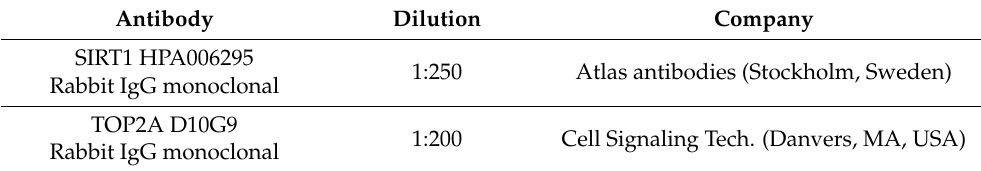
Table 5. Antibodies used for immunohistochemistry.